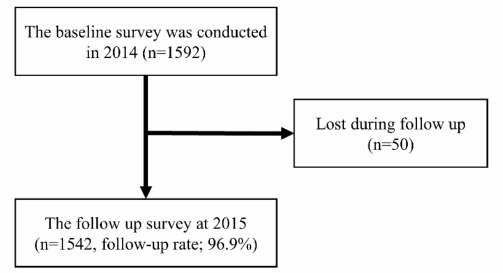
Figure 1. The participants flow for analytic sample ( n =